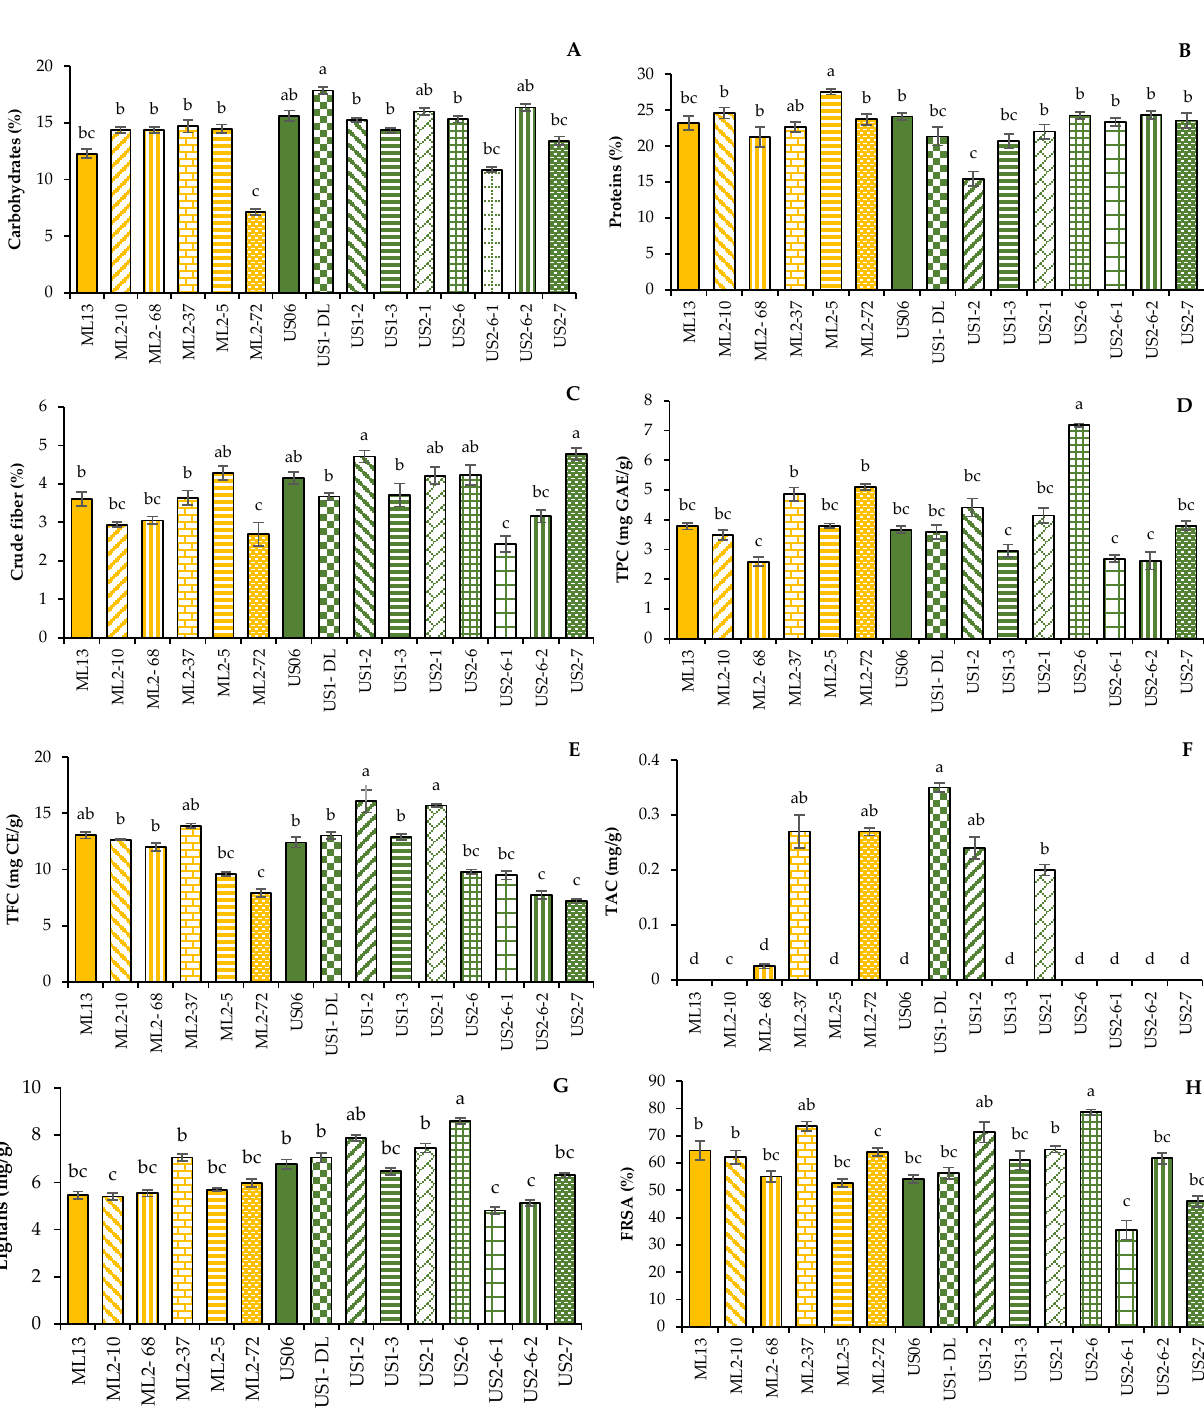
Figure 1. Differences among 13 M 3 sesame mutants and their wild-parents ( “US06” and “ML13” ) for some nutritional parameters and antioxidant activity: carbohydrate content ( A ), protein content ( B ), crude fiber content ( C ), TPC or total polyphenol content ( D ), TFC or total flavonoid content ( E ), TAC or total anthocyanin content ( F ), total lignans content ( G ) , and percentage of FRSA or free radical scavenging activity ( H ). Values with the same alphabetical superscripts are not significantly different according to the DMRT test ( p > 0.05).